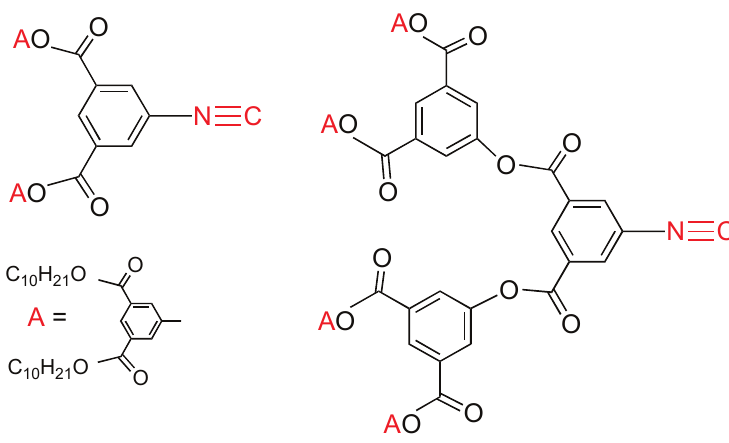
Figure 11. First and second-generation isocyanide dendrons.